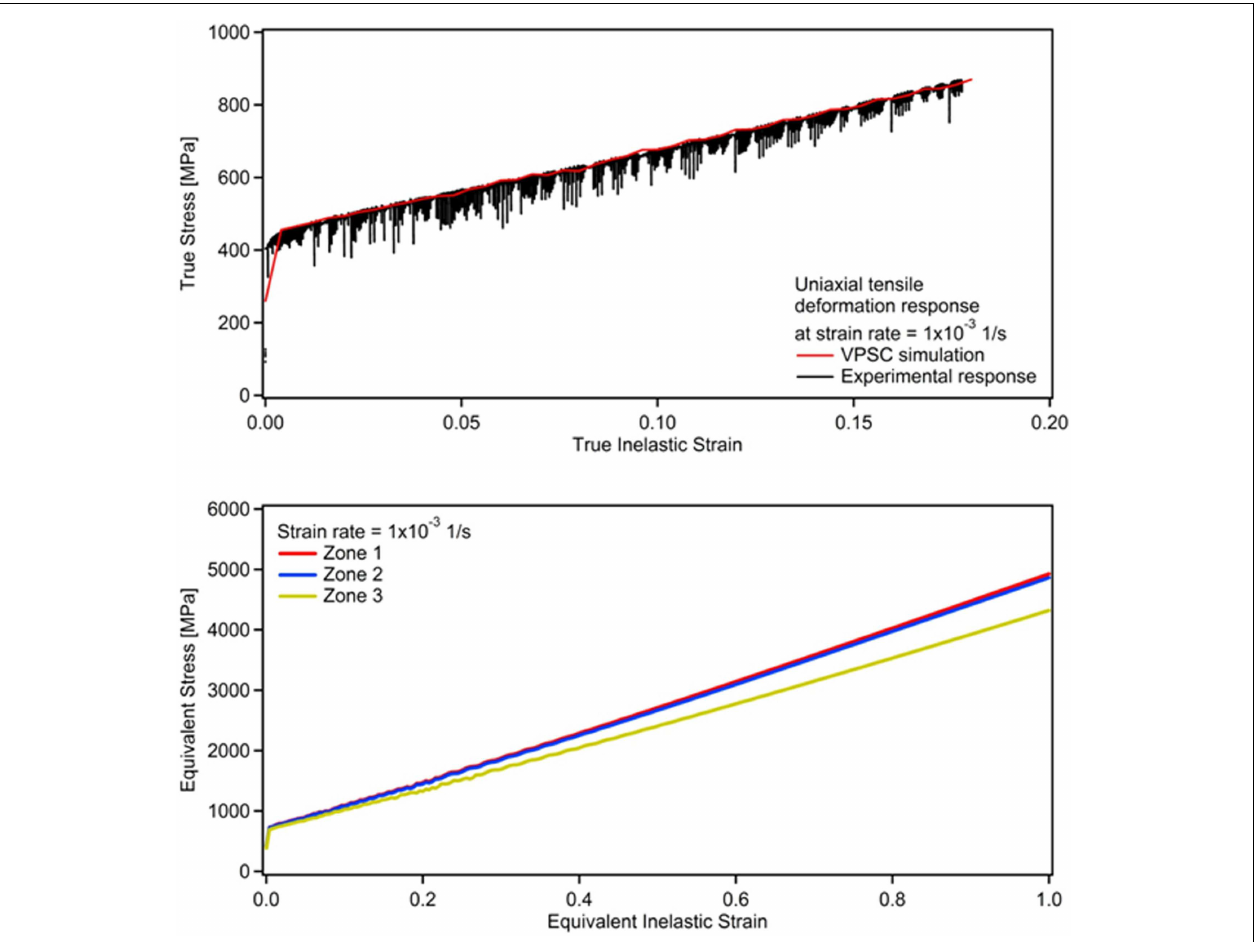
FIGURE 7 |Top:VPSC simulation of the RT experimental uniaxial tensile deformation of Hadfield steel at a strain rate of 1 × 10 − 3 1/s . Bottom: the corresponding predicted equivalent stress–strain response for each zone within the impact sample based on the distribution of stress concentration ( Figure 4